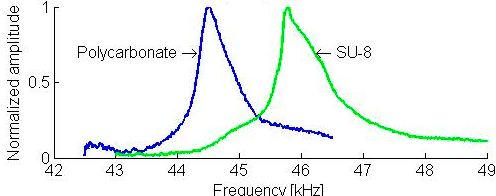
Figure 45. The contact resonance spectra of the second flexural mode of a 5-mm long piezo-resistive cantilever microprobe in mechanical contact with a polycarbonate (blue curve) and an SU-8 sample.